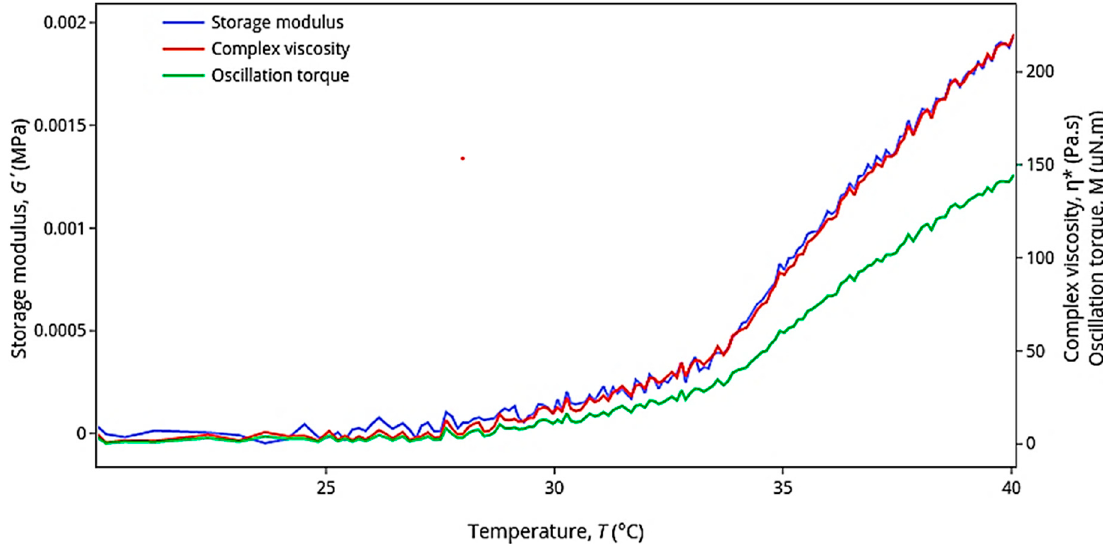
Figure 7. Rheological graph of the thermosensitive gel system expressing the storage modulus (G’), complex viscosity ( η *), and oscillation torque (M) as a function of temperature (T).